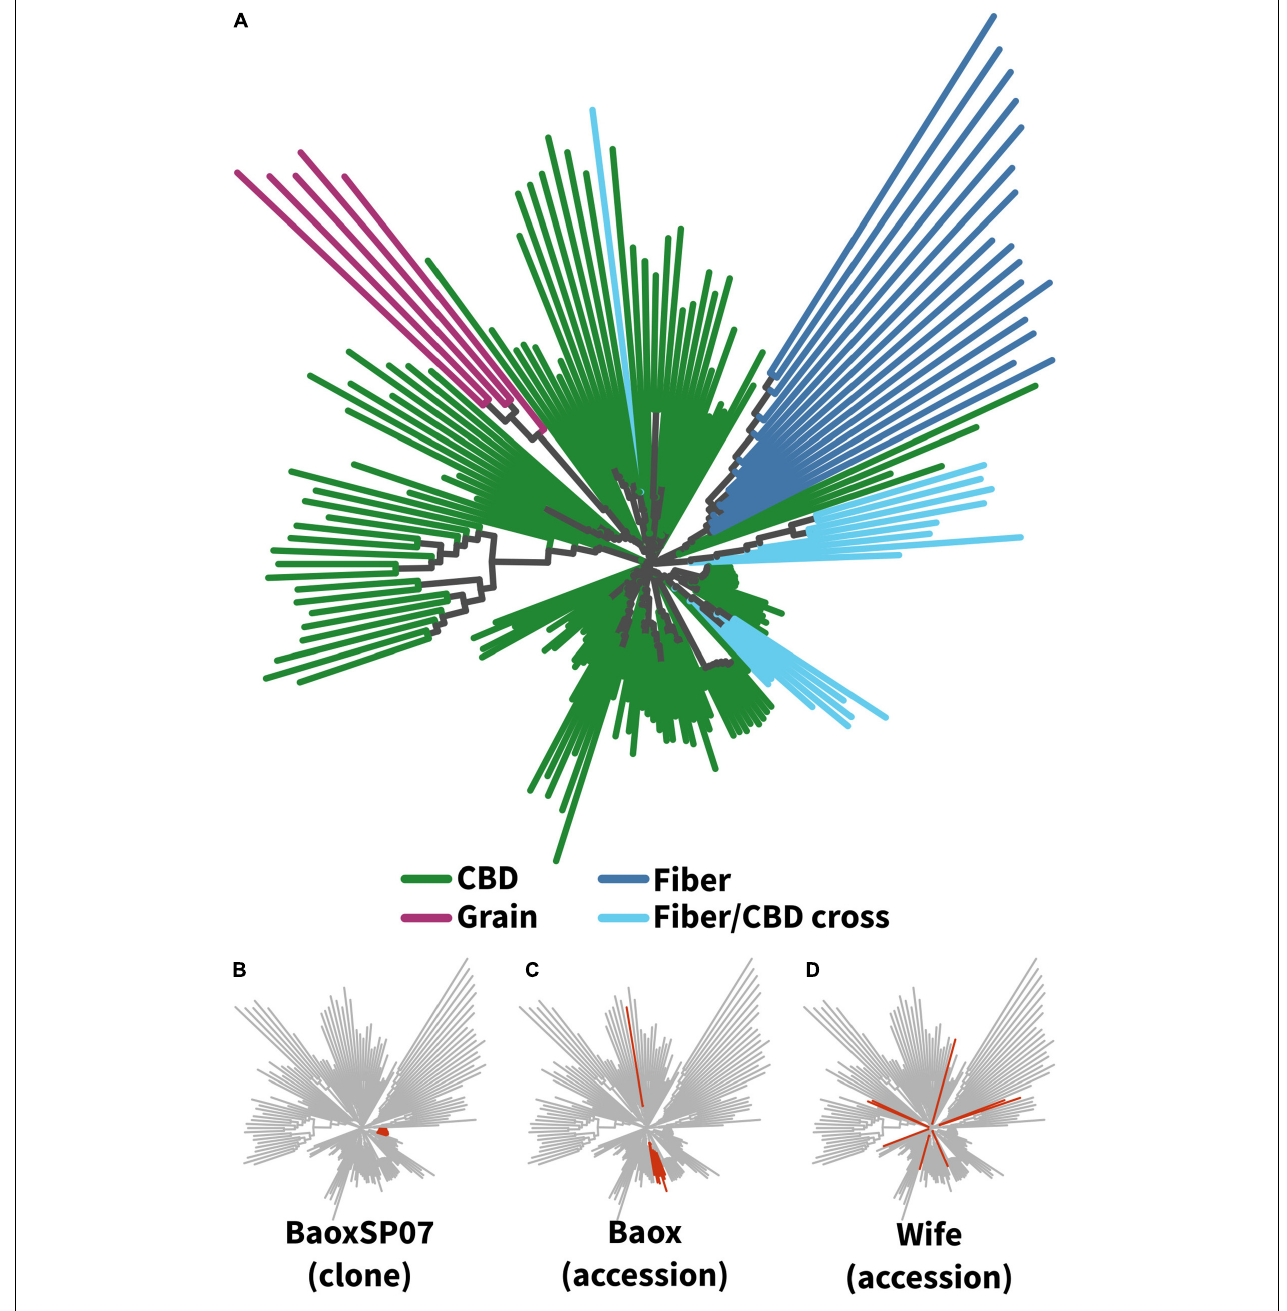
FIGURE 1 | Relationships among accessions based on a neighbor-joining tree of SNP data. (A) All plants (173 plants from 22 accessions). Branch tips are colored by use type. (B–D) Variation among individual accessions. All individuals within the clonal variety “BaoxSP07” (B) cluster tightly, whereas the seed accession “Baox” (C) shows more variation, including one off-type. Importantly, although both B,C are supposedly Baox, they do not cluster with each other on the tree. (D) The “Wife” accession showed extreme variation, with individual plants scattered across the entire tree. (See Supplementary Figure 2 for more details on individual